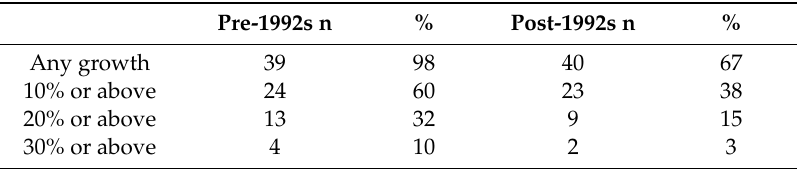
Table 2. UCAS data: three years growth (2012 / 13–2014 / 15). Pre-1992s n